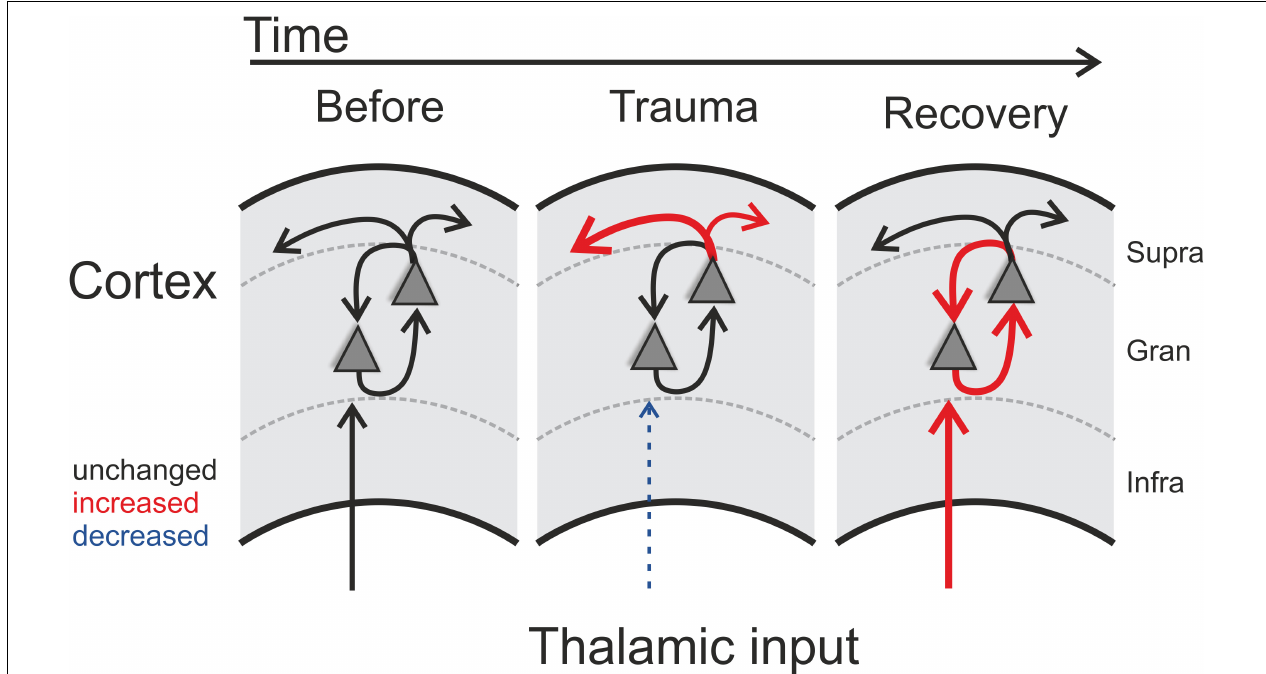
FIGURE 5 | Schematic illustration of trauma-induced changes over time. Note that each panel represents one cortical recording patch with lateral corticocortical connections represented by the uppermost arrows (supragranular layer boundary, gray dashed lines), local intracolumnar connections in the granular layer boundaries, and corresponding thalamocortical inputs that arise via the infragranular layer boundaries. Acoustic trauma led to increased auditory thresholds, which we found to be present over the entire tonotopic gradient (cf. Figure 1C ). On a columnar level, as indicated by the scheme, this can be explained by noise-trauma induced decreased strength of local thalamic input to ACx (indicated by dashed thin blue arrow in middle panel; cf. Figures 3A,D ). While overall columnar activity was consistently decreased across the tonotopic gradient, the relative contribution of corticocortical activity was increased immediately after the trauma (upper red arrows in middle panel; cf. Figure 2 ). After recovery over weeks, these acute effects were reversed: while increased sensory input from thalamus was now coupled with an increased local intracolumnar gain of tone-evoked cortical activity (red arrows in right panel; cf. Figure 4 ), the recruitment of lateral corticocortical circuits was relatively decreased to pre-trauma condition levels or even below (for frequency regions above trauma, blue dashed arrow in right panel) (cf. Figure 2 ).